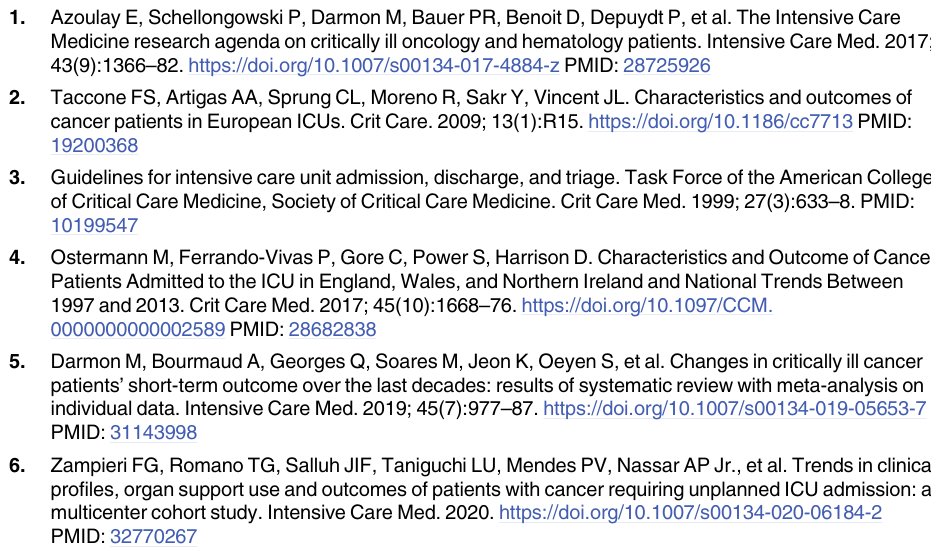
S10 Table. Outcome of patients with an active solid malignancy versus patients with an active hematological